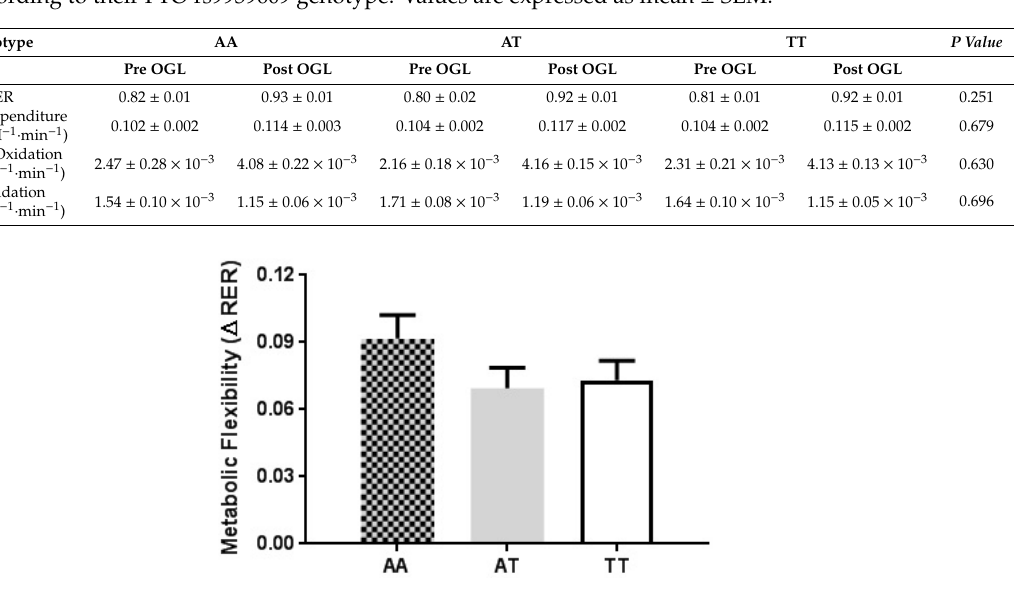
Figure 1. Metabolic flexibility measured as the ∆ RER 60 min post OGL compared to pre OGL, with participants separated on their FTO rs9939609 genotype. Values expressed as mean ± SEM. Power analysis results for RER ( η p 2 = 0.020; 1- β = 0.690), energy expenditure ( η p 2 = 0.006; 1- β = 0.888), glucose oxidation ( η p 2 = 0.007; 1- β = 0.876) and fat oxidation ( η p 2 = 0.005; 1- β = 0.893) are